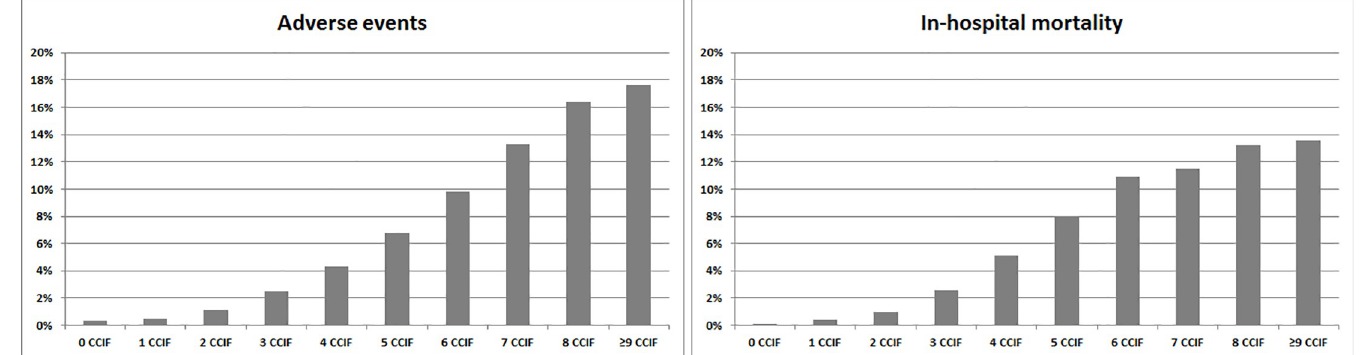
Fig 1. Proportions of AE and in-hospital mortality according to the number of care complexity individual factors.